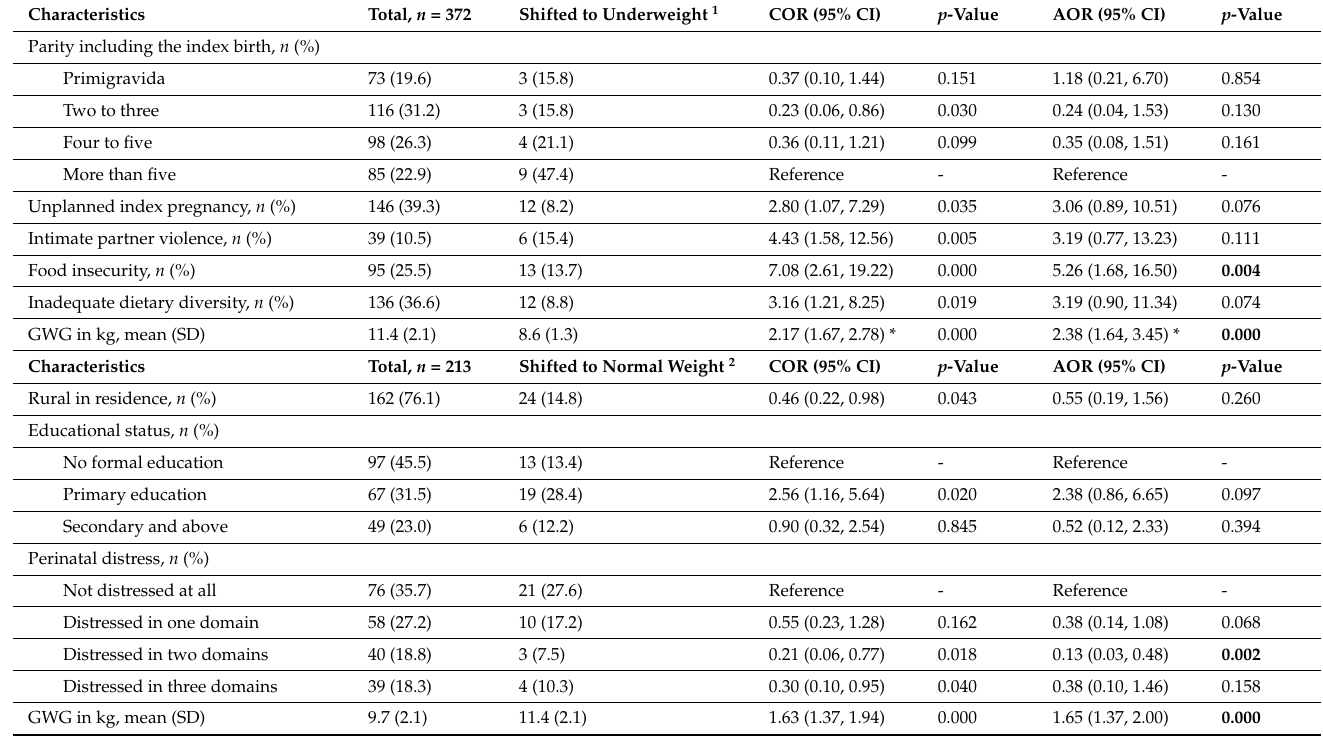
Table 3. Factors associated with a change in BMI category at 18 to 24 months